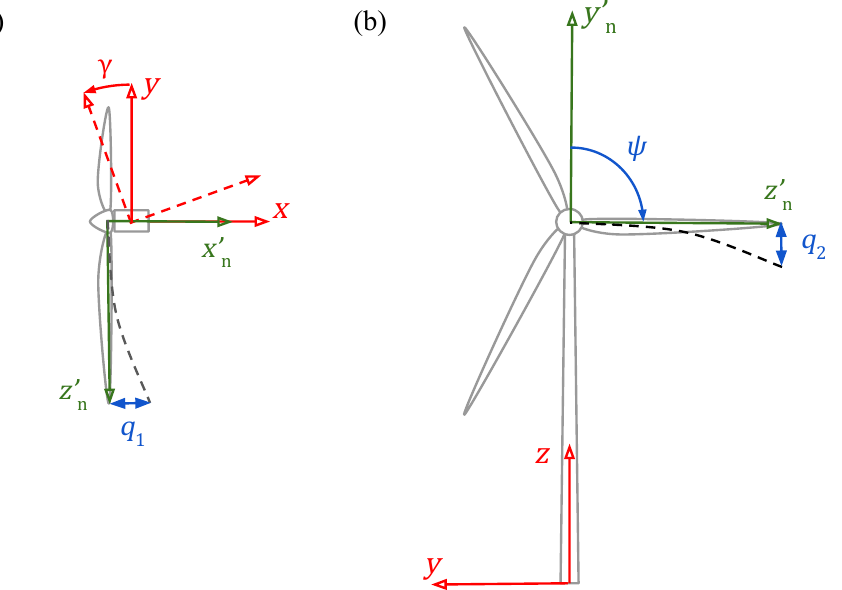
Figure 1. The ground-fixed coordinate system x - y - z for solving the filtered Navier–Stokes equations and the blade-following coordinate system x (cid:48) n - y (cid:48) n - z (cid:48) n for solving the Euler–Bernoulli beam equations for the n th blade: ( a ) top view and ( b ) front view. ψ is the phase angle of the blade. γ is the yaw angle of the turbine. The positive directions of ψ and γ follow the right-hand